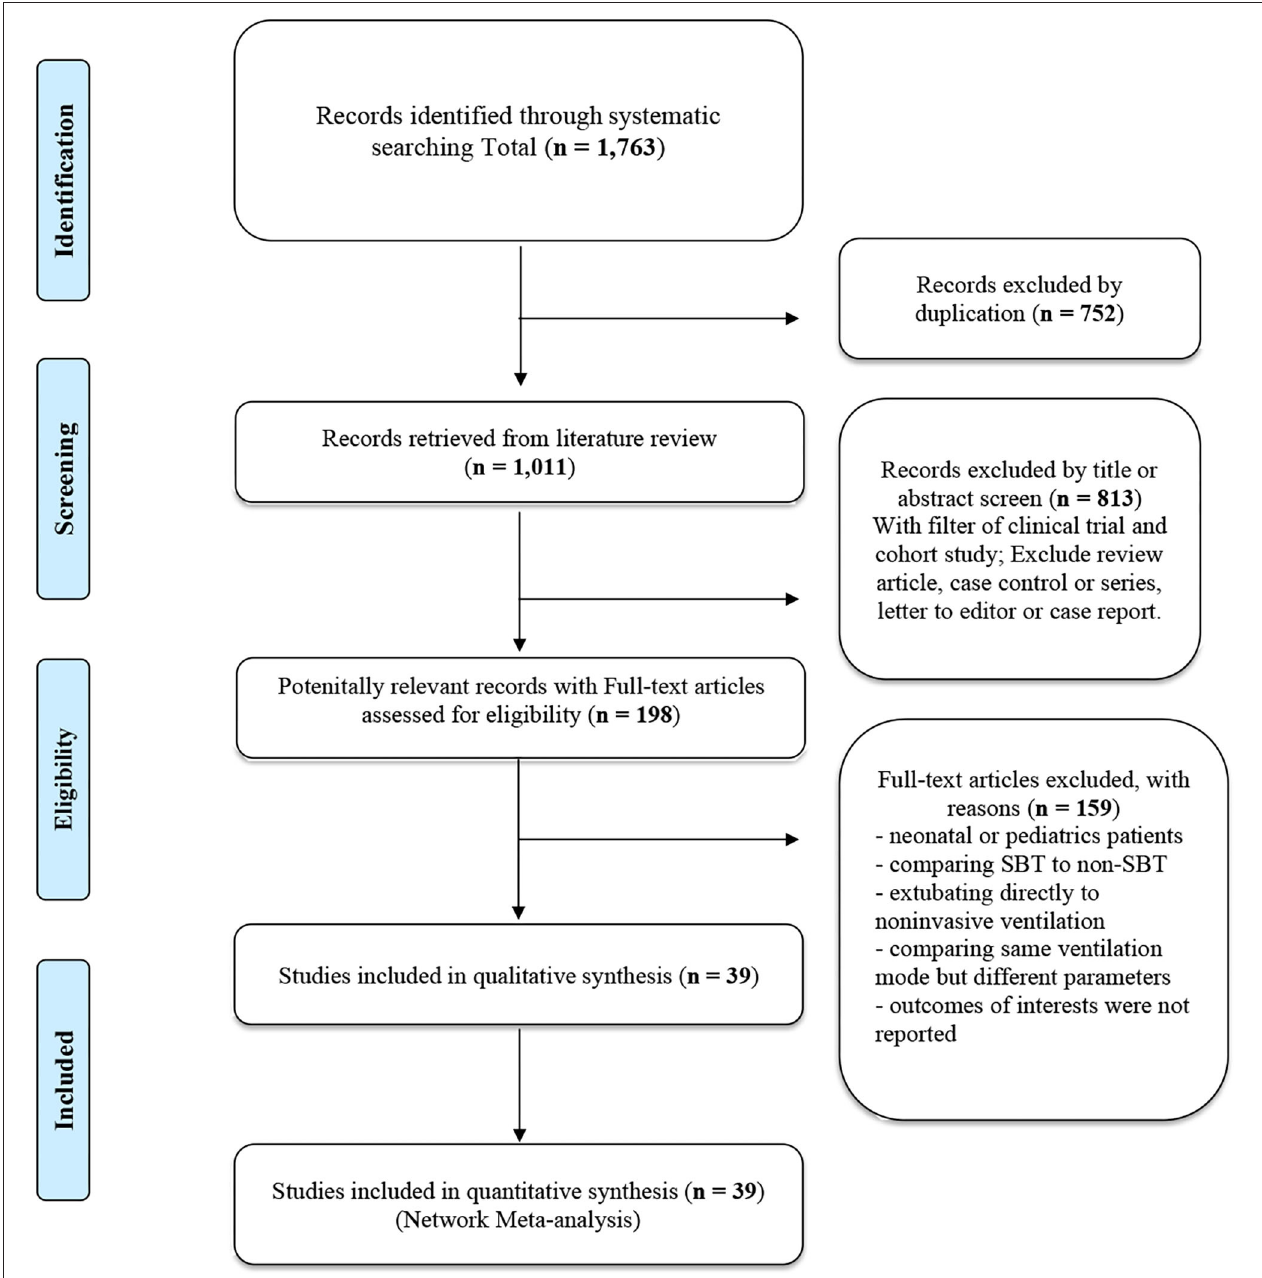
FIGURE 1 | PRISMA flow diagram of included